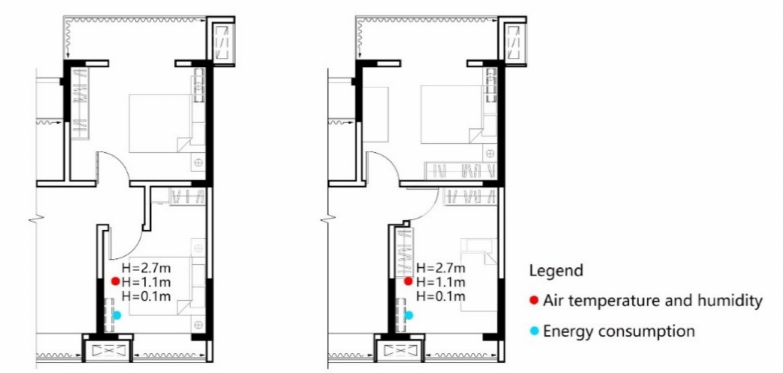
Figure 9. Layout of the measuring instruments, renovated unit (left), and original unit (right).